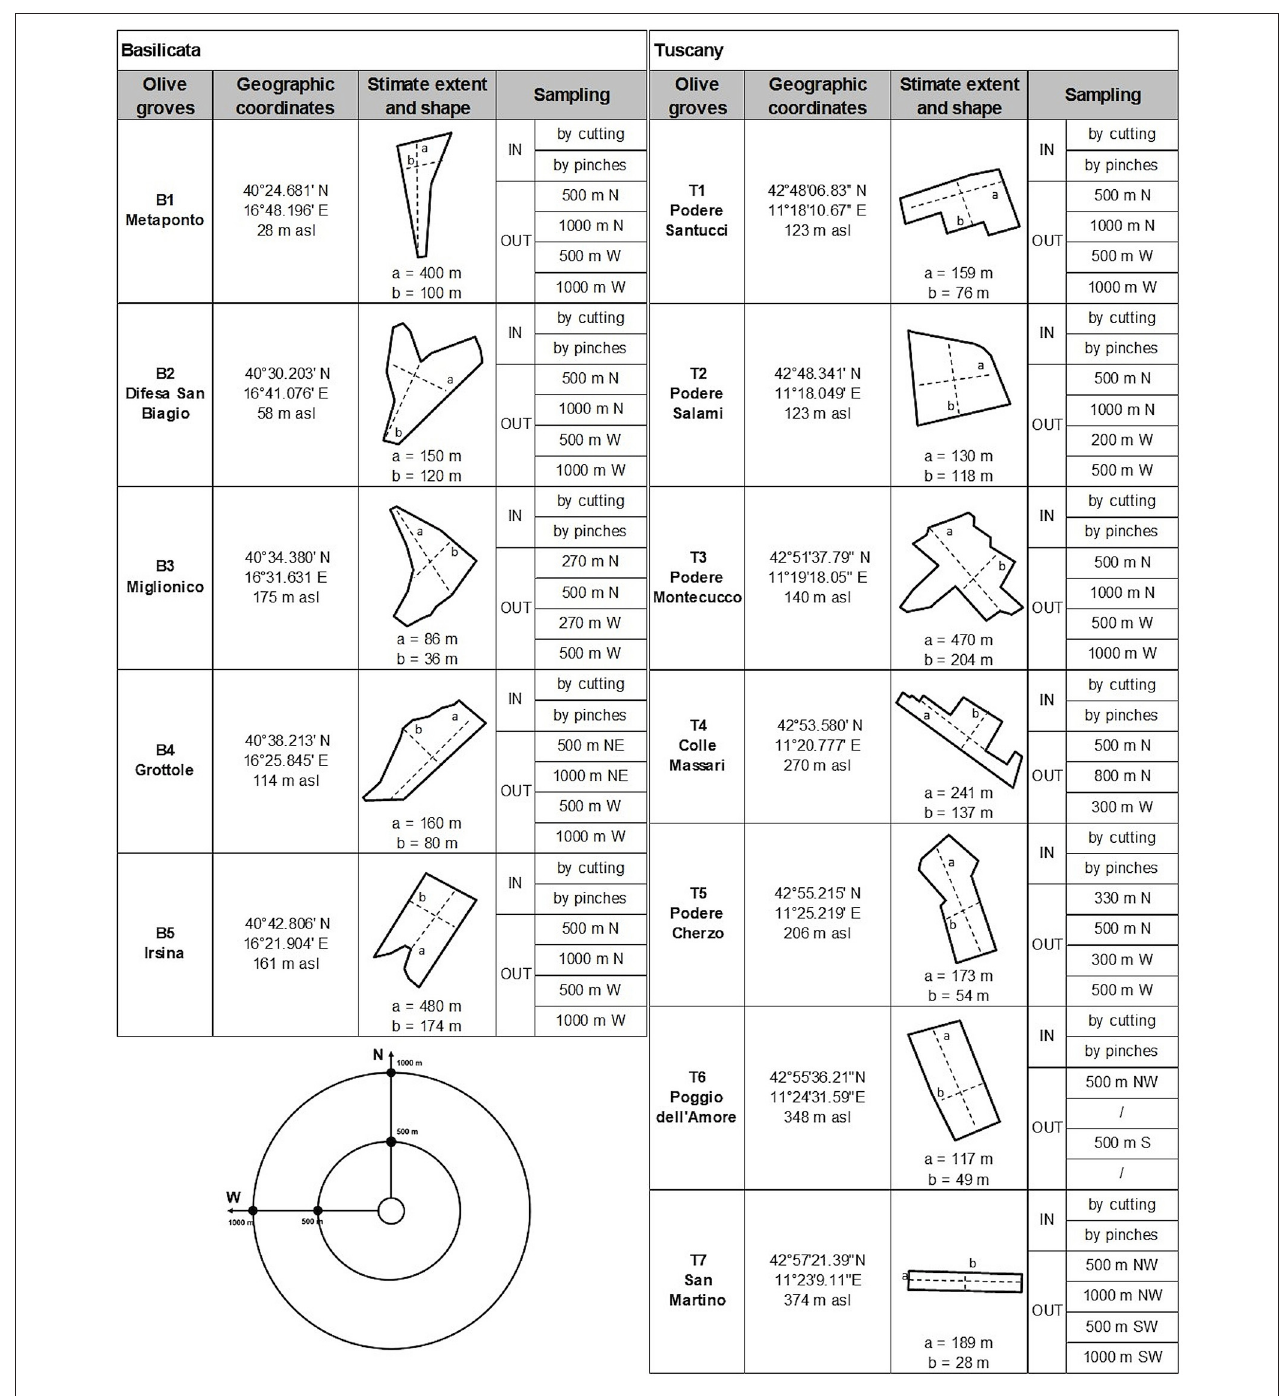
FIGURE 3 | Surface pollen samples taken from the olive groves located in Basilicata (B) and Tuscany (T), Italy; the geographical coordinates, size of the plantation, and type of sampling are shown. a, maximum length; b, maximum width; IN, samples taken from the center of the olive groves; OUT, peripheral samples. The olive grove extent is that for the sampling year (2010 for Basilicata, 2011–13 for Tuscany). Bottom left: the model of pollen sampling in the olive groves.